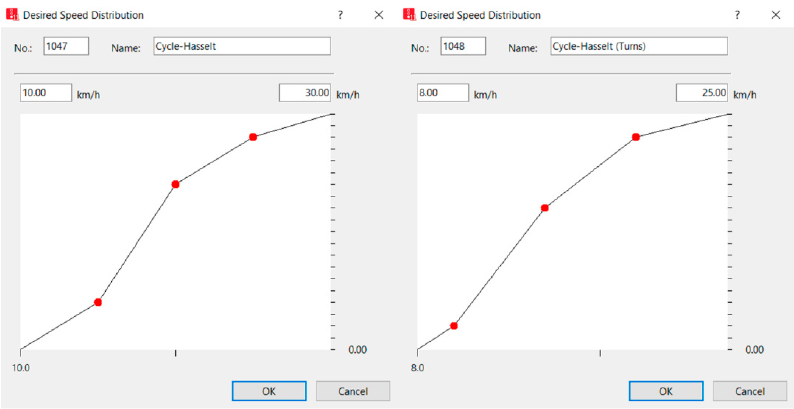
Figure 4. Implemented speed distributions for cyclists for normal routes ( left ) and turns ( right ).